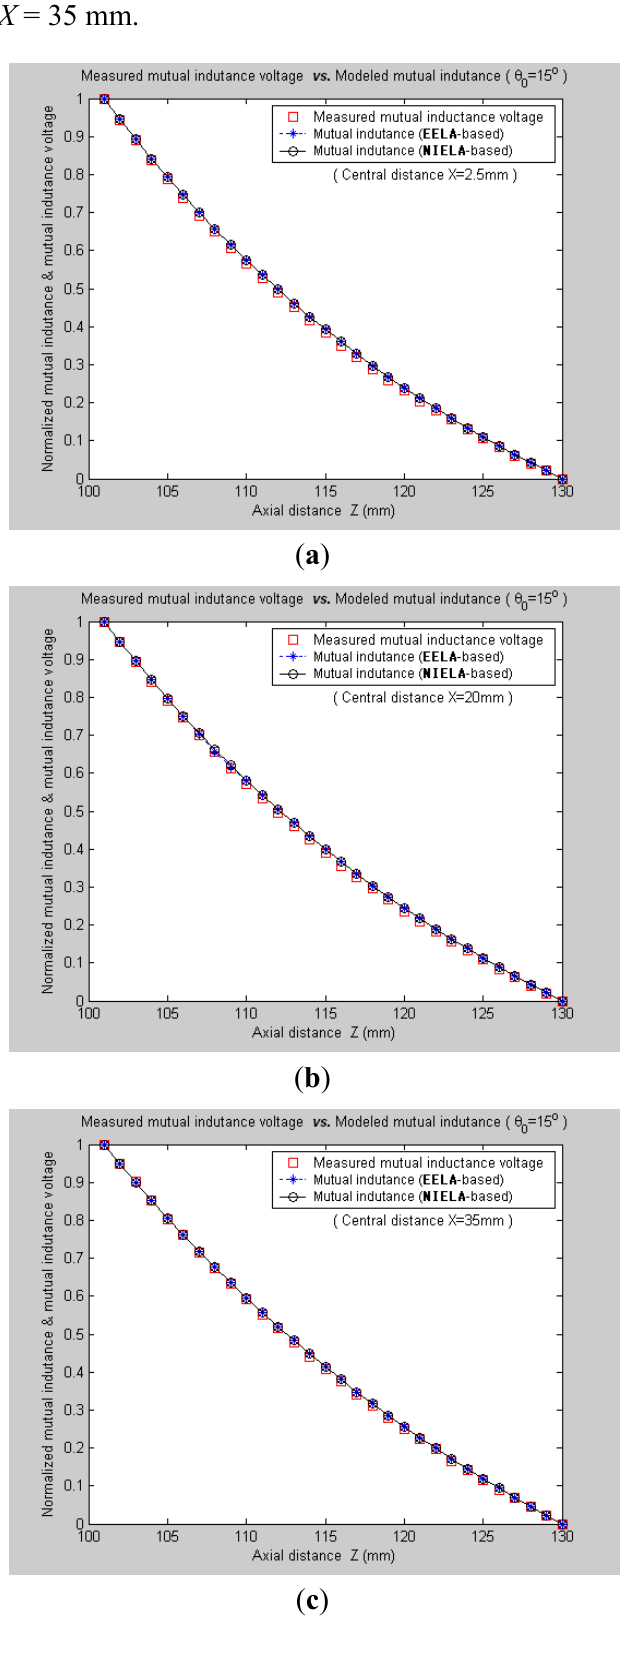
= 15°. ( a ) X = 2.5 mm; 0